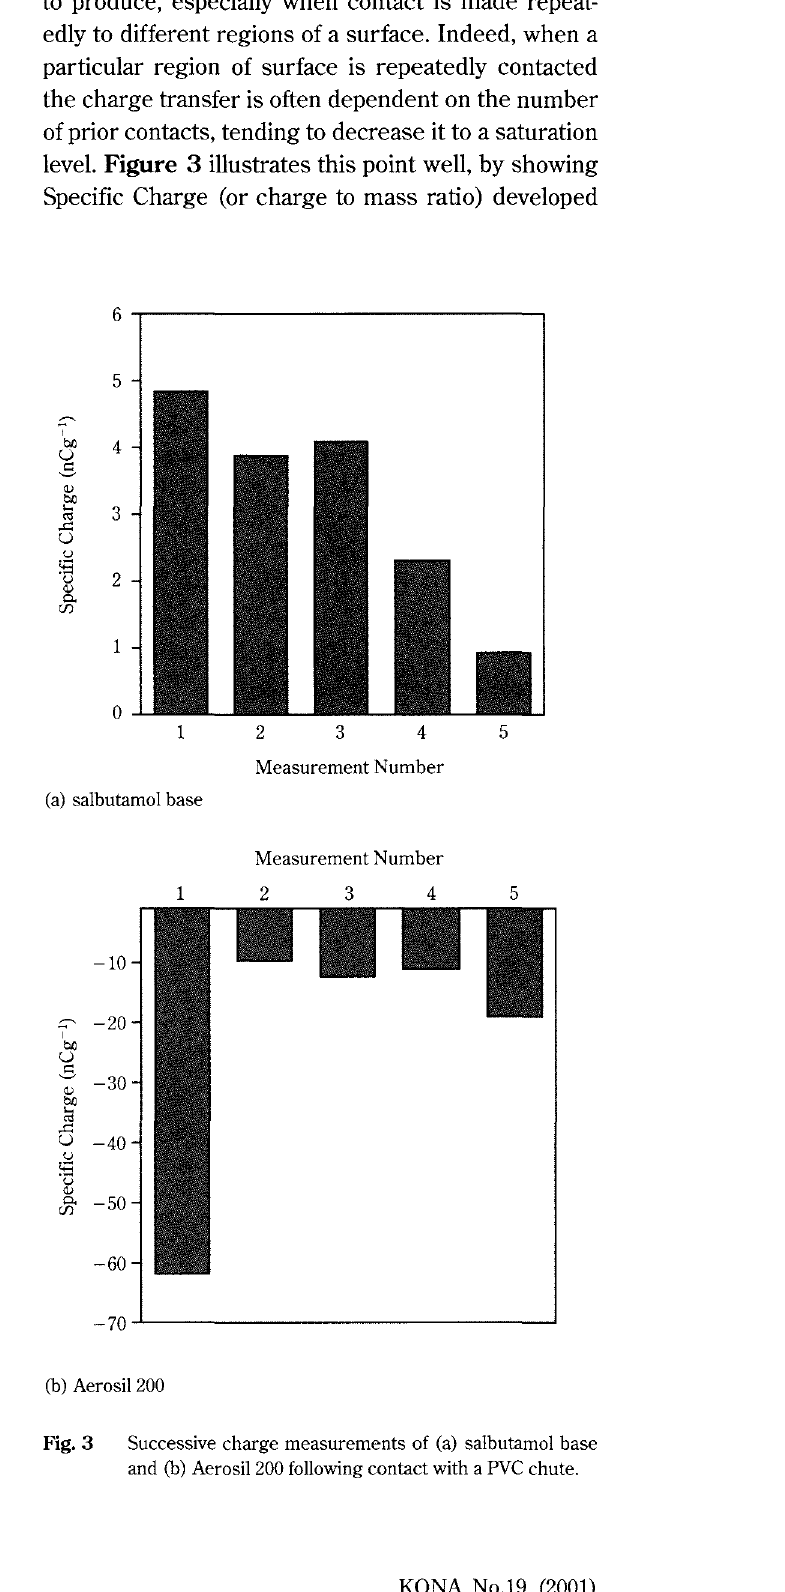
Successive charge measurements of (a) salbutamol base and (b) Aerosi1200 following contact with a PVC